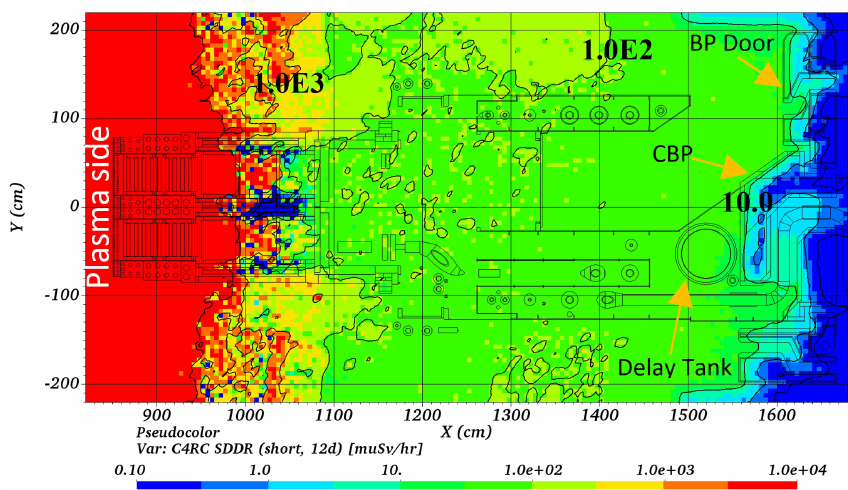
Figure 15. SDDR [ µ Sv/h] for the baseline configuration (C4RC) at 12days following Short scenario.